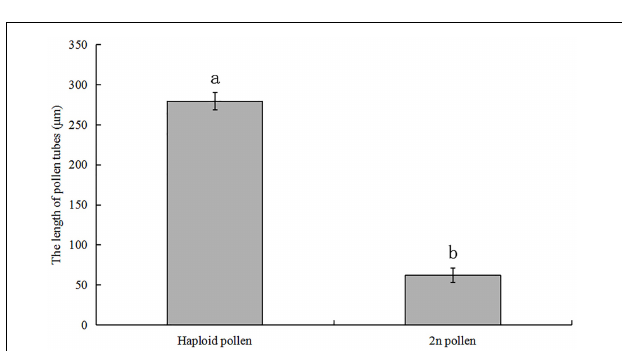
FIGURE 5 | Germination rates of natural 2n pollen derived from the control group and colchicine-induced 2n pollen derived from the treatment given 11 injections with 0.5% colchicine at pachytene in P. canescens .